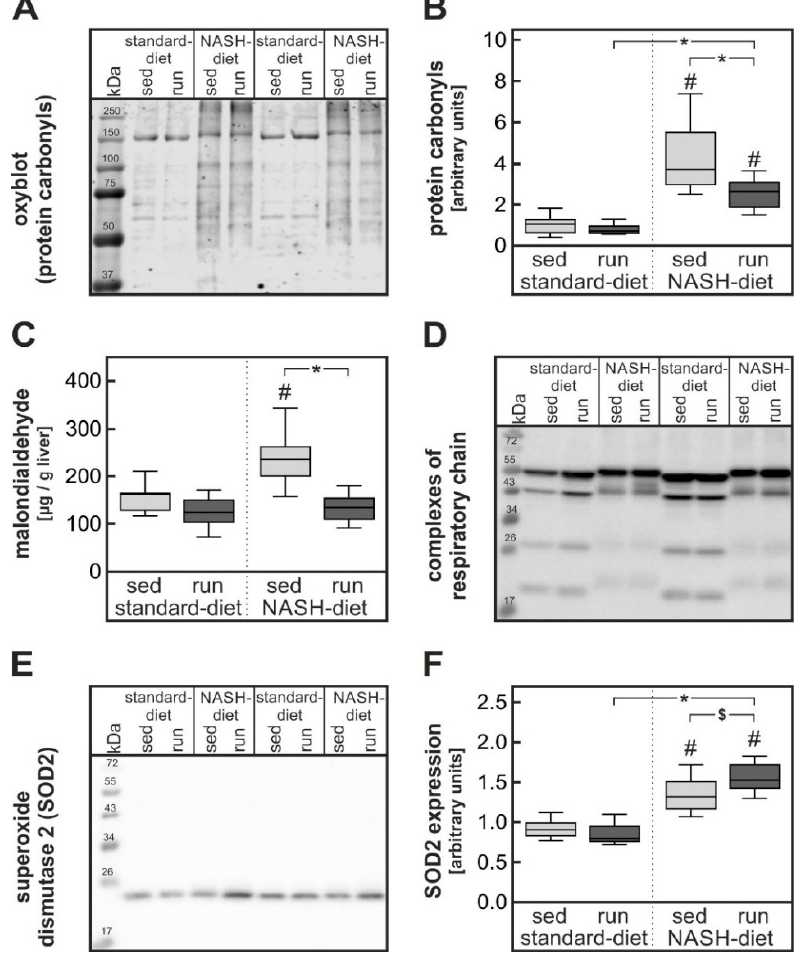
Figure 5. Exercise-dependent reduction of NASH-diet-induced hepatic oxidative stress and exercise-dependent increase of NASH-diet-induced hepatic anti-oxidative capacity. Parameters were determined in liver samples of rats of the different intervention groups described in the legend to Figure 1. ( A , B ) Protein carbonyls were detected by oxyblot as a measure of severe oxidative stress. A representative blot is shown ( A ). All blots, as well as Ponceau S staining as a loading control, are available as Supplementary Figure S2. Blots of livers of all animals were subjected to densitometric quantification ( B ). ( C ) Malondialdehyde as a parameter for lipid peroxidation and mild oxidative stress was measured in liver homogenates by TBARS assay. ( D ) Hepatic expression of the complexes of the respiratory chain was determined by western blot. A representative blot is shown. All blots as well as the quantification are available as Supplementary Figure S3. ( E , F ) Hepatic expression of superoxide dismutase 2 (SOD2) measured by western blot. A representative blot is shown ( E ). All blots are available as Supplementary Figure S4. Blots of livers of all animals were subjected to densitometric quantification (SOD2 relative to FastGreen staining as a loading control) ( F ). Values are median (line), upper and lower quartile (box) and extremes (whiskers). Statistics: Two-way-ANOVA with Tukey’s post hoc test for multiple comparisons; #: significant versus sedentary standard-diet group, * p < 0.05 between compared groups; $: p = 0.070 between compared